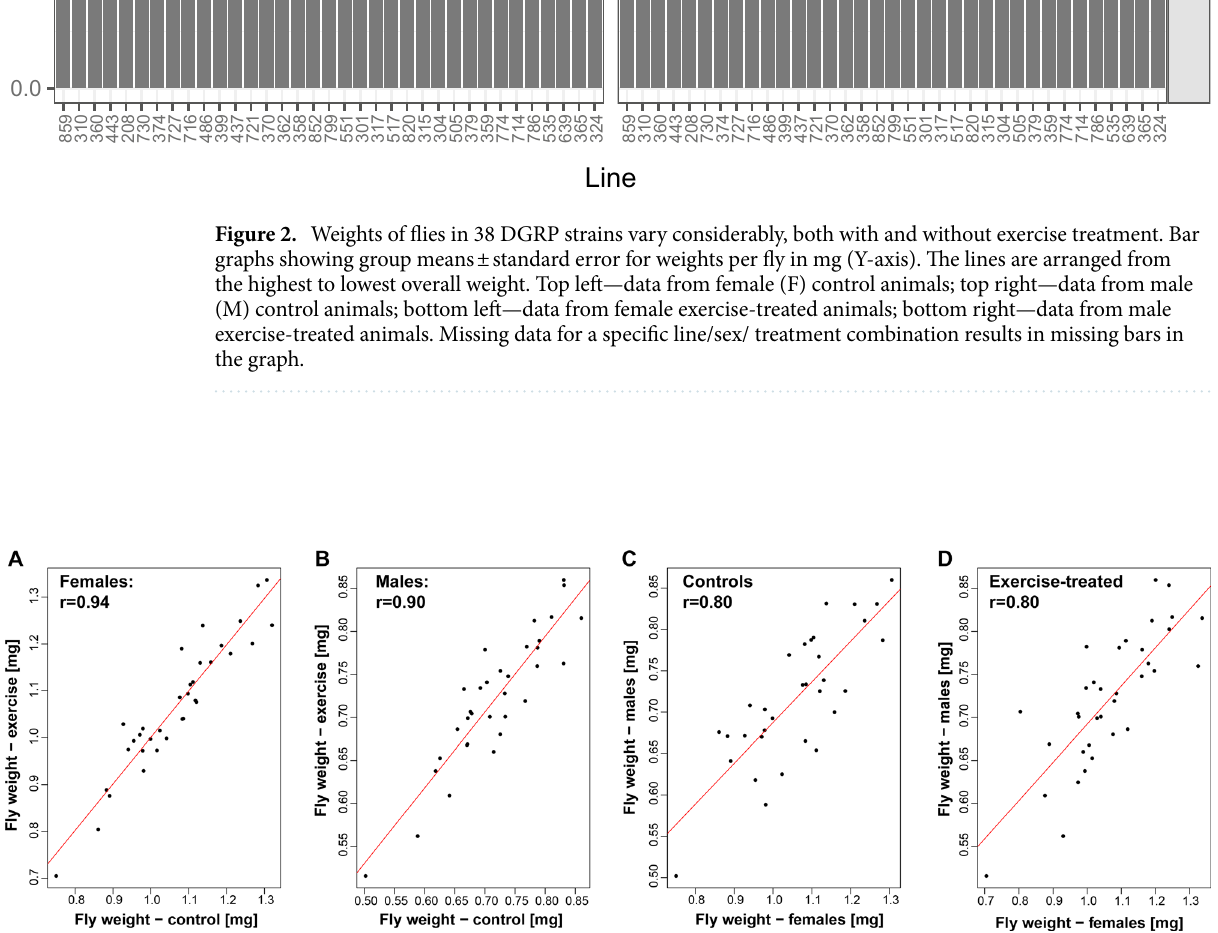
Figure 3. Animal weights are strongly correlated between male and females of the same strain, irrespective of exercise. X- and Y-axis: Weight per fly in mg. r: Pearson’s product-moment correlation. ( A ) Data from females; X-axis—control animals; Y-axis—exercise-treated animals. ( B ) Data from males; X-axis—control animals; Y-axis—exercise-treated animals. ( C ) Data from control animals; X-axis—females; Y-axis—males. ( D ) Data from exercise-treated animals; X-axis—females;